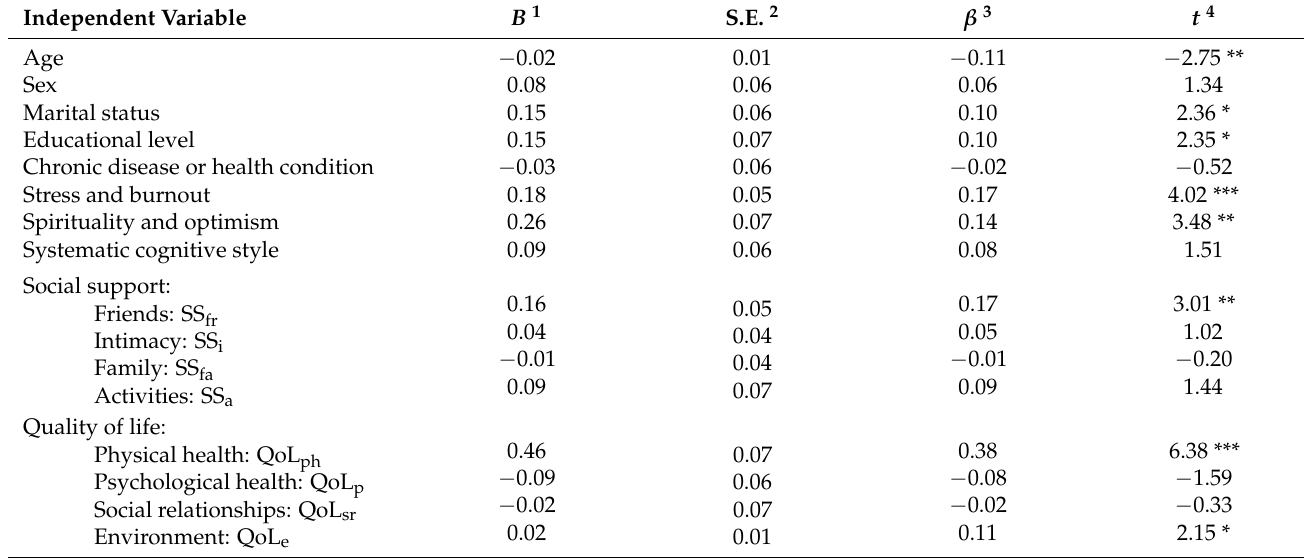
Table 7. Results of a multilinear regression model that was designed using the purpose in life total score as the dependent variable, involving only